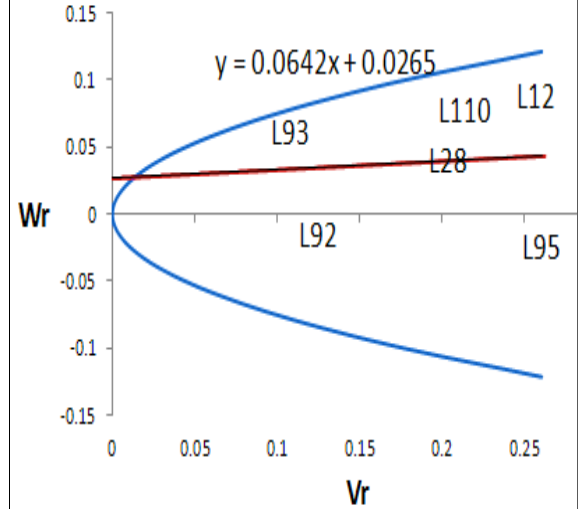
Fig. 5a: Wr/Vr graphs for number of branches per plant under NI